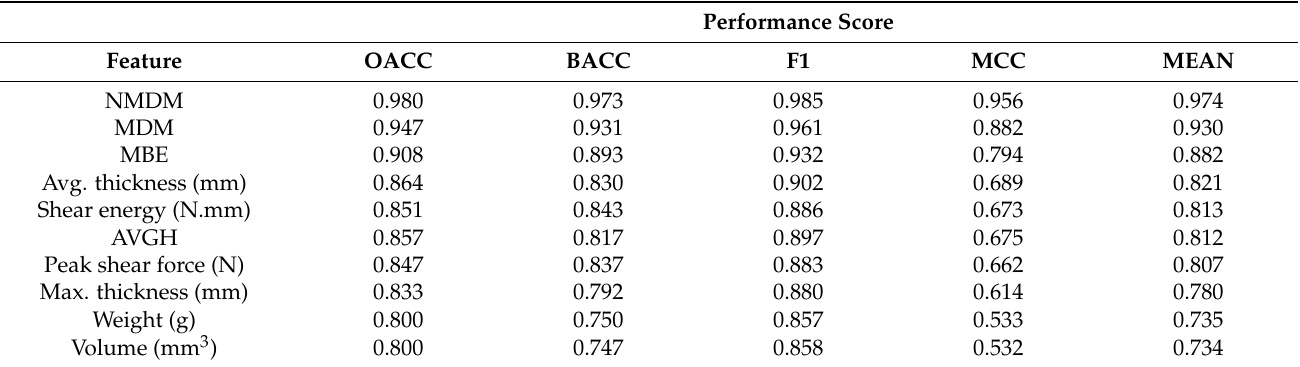
Table 4. Performance of SVM model: Average of 10 repeated five-fold cross-validations. The results for MDM, NMDM, MBE, and AVGH were the averages over all line speeds (10, 50, and 100 FPM).